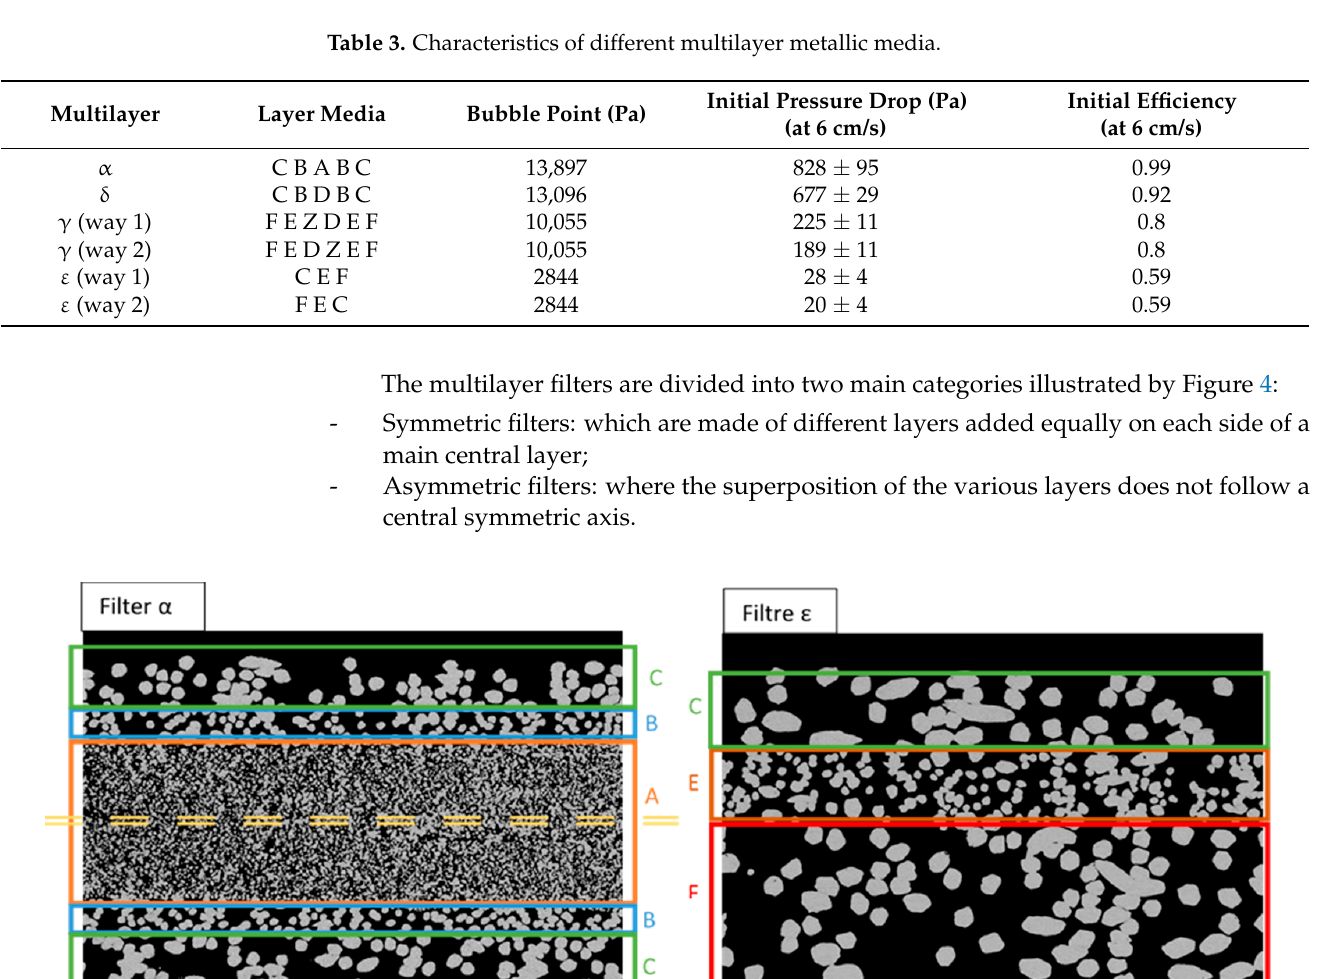
Table 3. Characteristics of different multilayer metallic media.